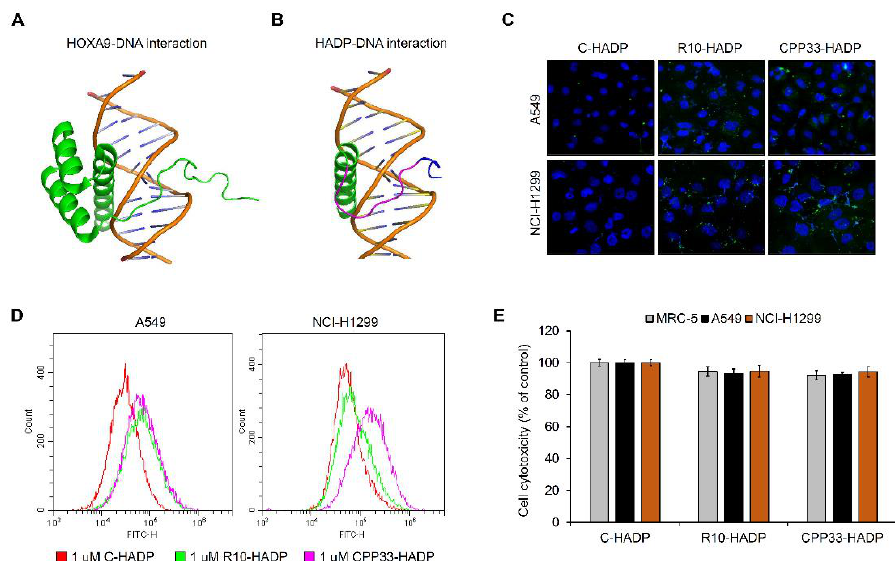
Figure 3. Structure and intracellular transduction of synthetic cell-permeable peptide HADP. ( A ) The HOXA9-DNA complex was reported by LaRonde-LeBlanc (2003). ( B ) Docking simulation between HOXA9-HADP and DNA using PyMOL analysis. Blue indicates the linker motif of HOXA9 protein, and red represents the N-terminal arm motif of HOXA9 protein. Green refers to the a-helix motif of HOXA9 protein. ( C ) Visualization of intracellular cell-penetrating peptides using immunofluorescence microscopy. All images are shown at 200× magnification. ( D ) Estimation of intracellular cell-permeable peptides using FACS analysis. ( E ) Determination of cell cytotoxicity using an MTT assay in cell-permeable peptides treated cells.